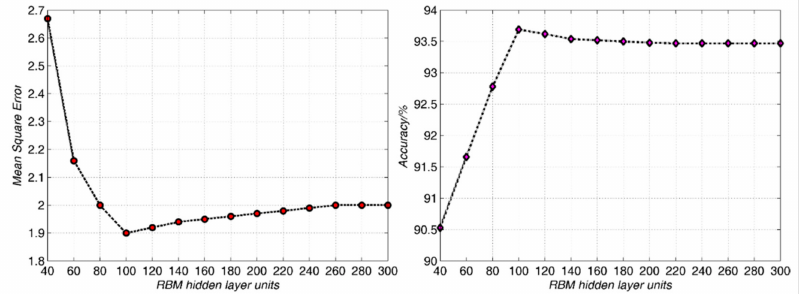
Figure 10. The output mean square errors and classifications in different RBM hidden layer nodes for the Qionglai